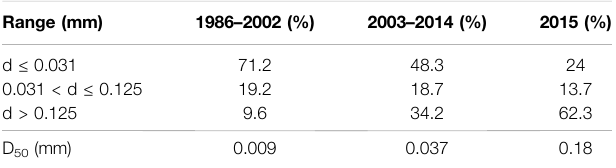
TABLE 1 | Percentage of different suspended sediment grain sizes at the Jianli hydrological